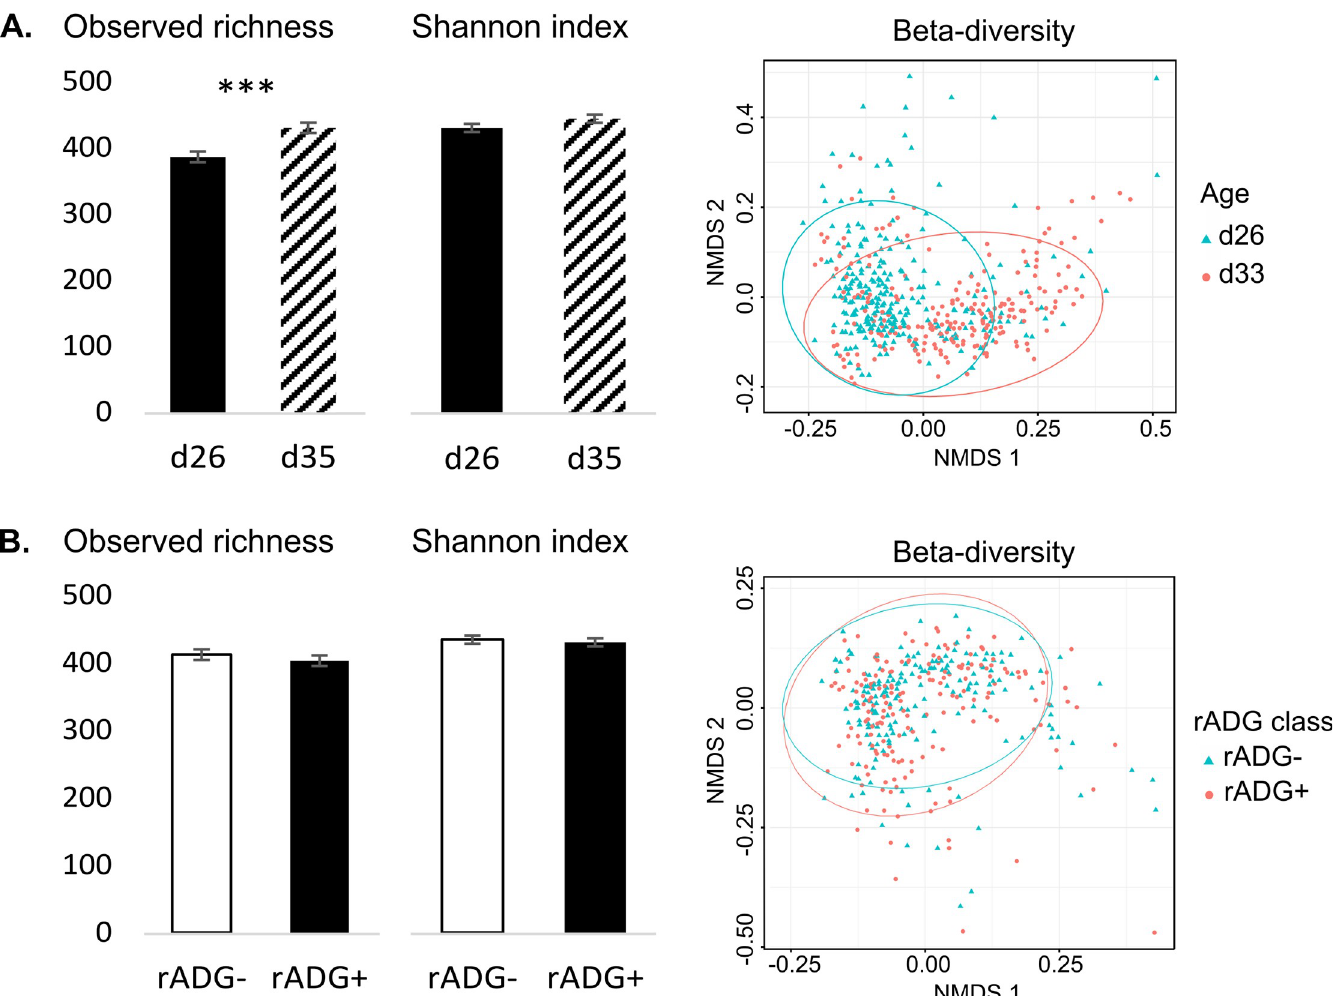
Fig 1. Influence of age (A) and rADG class (B) on alpha and beta diversity of piglet fecal microflora. Samples were collected from suckling 26-day-old (n = 222) and weaned 35-day-old piglets (n = 254) from 16 commercial farms. They were classified according to their relative ADG (rADG) between d26 and d48 into high (rADG+) or low (rADG-) growth classes and the 20% pigs showing a median rADG were excluded. Alpha diversity was described by observed richness and Shannon index and beta diversity was expressed according to the non-metric multidimensional scaling (NMDS) on Unifrac distances calculated at the OTU level. For observed richness and Shannon index a significant effect of age or rADG class is indicated by � (P <